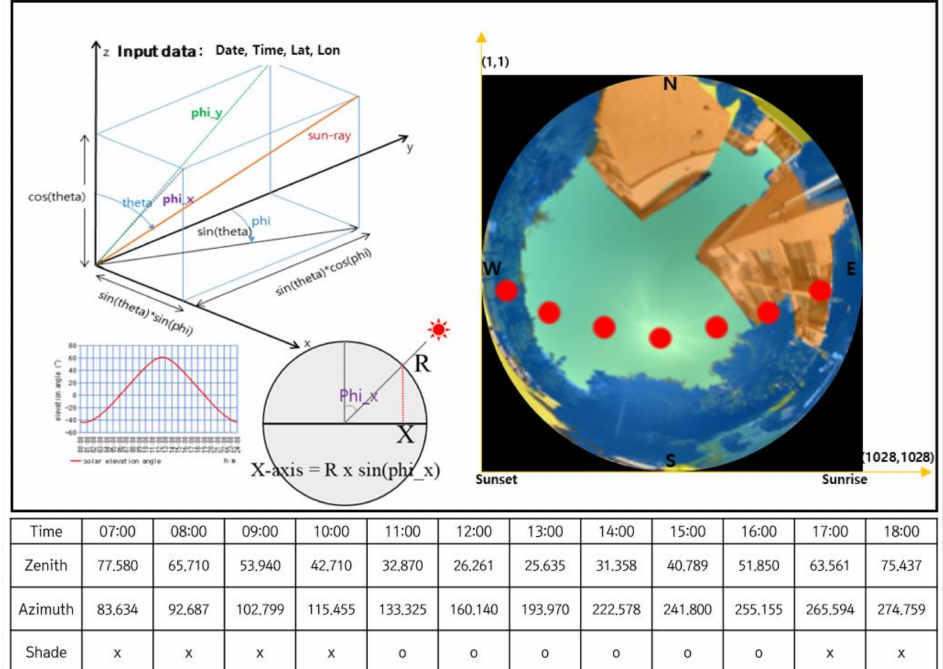
Figure 3. Solar path in fisheye image using input data (date, time, latitude, longitude). Red point shows the projected sun positions for 2020.08.18 on hemispherical images. For a person at the location of (126.9658, 37.5714) and time (t), when the red point (sun position) is located on the sky pixel in the hemispherical images, the person is exposed to direct sunlight. If the sun position is on non-sky pixels, the person at that time is shaded from